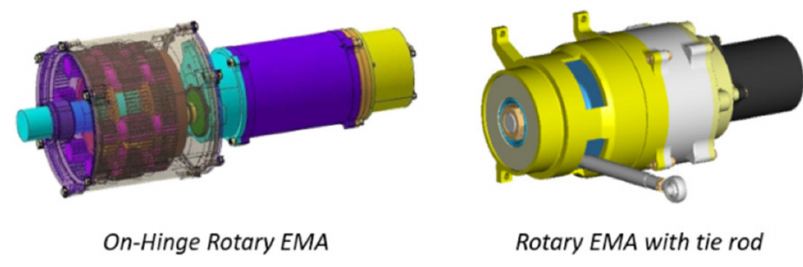
Figure 21. Geared rotary actuators (adapted from [42]).